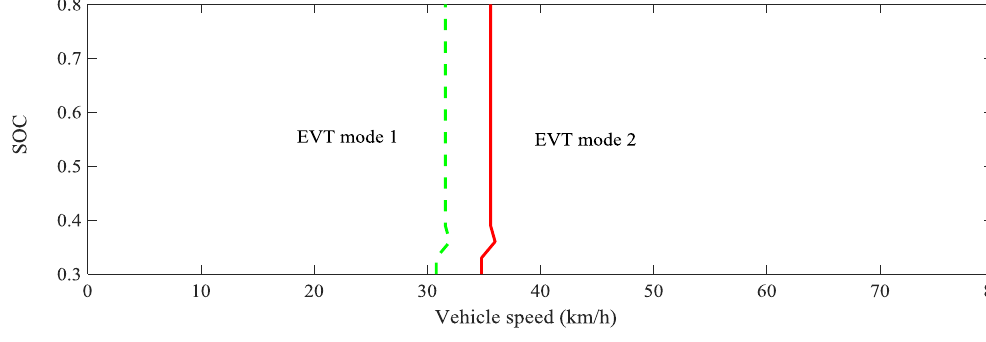
Figure 9. Dynamic shift schedule of the hybrid HDV with PST.